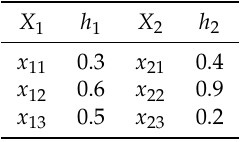
Table 2. An example of two functions defined over the marginal spaces.